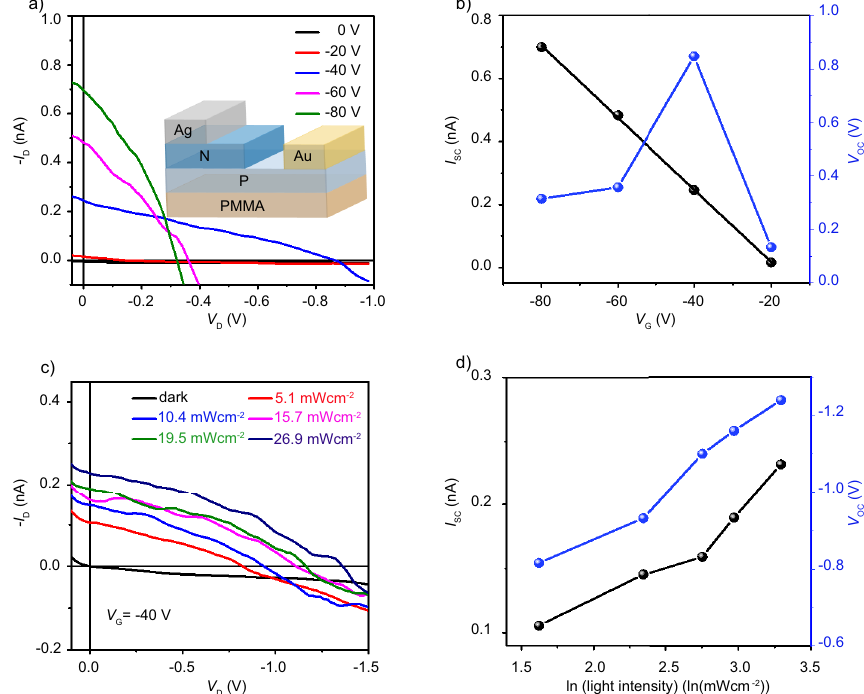
Fig. 4 Photovoltaic performance of bimolecular layer NDI (n type)-C 6 DPA (p type) heterojunction devices. a Current – voltage characteristics of the device with different gate voltages under the white light illumination (26.9 mW cm − 2 ). Insert: the structure diagram of the organic photovoltaic (OPV) device. c Current – voltage characteristics of the device with different light intensities at V G = − 40 V. The dependence of short circuit current ( I sc ) and open circuit voltage ( V oc ) on gate voltage ( b ) and light intensity ( d